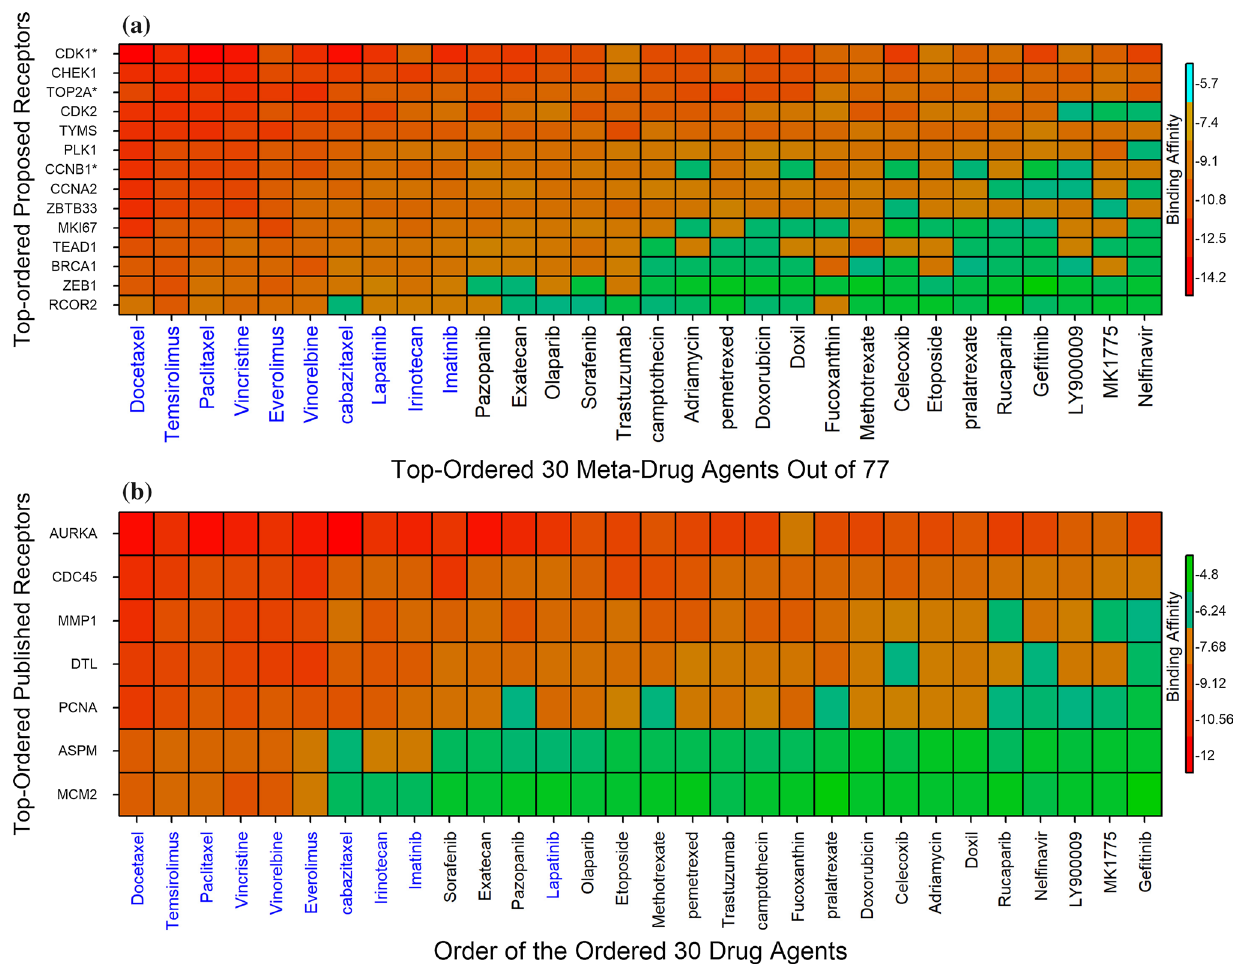
Fig. 5 a Image of binding affinities based on the top-ordered 30 meta-drug agents out of 77 against the ordered 15 receptors, where red colors indicated the strong binding affinities, and the single star (*) indicated common receptors (published and proposed). b Image of binding affinity scores based on the ordered proposed 30 candidate-drugs in X-axis and Top-ordered 10 published proteins corresponding to CC in